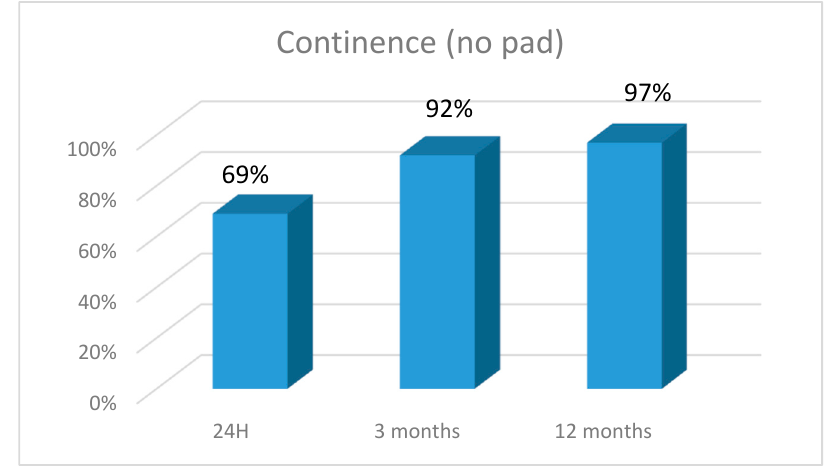
Figure 1. Continence rate after Perusia RARP.